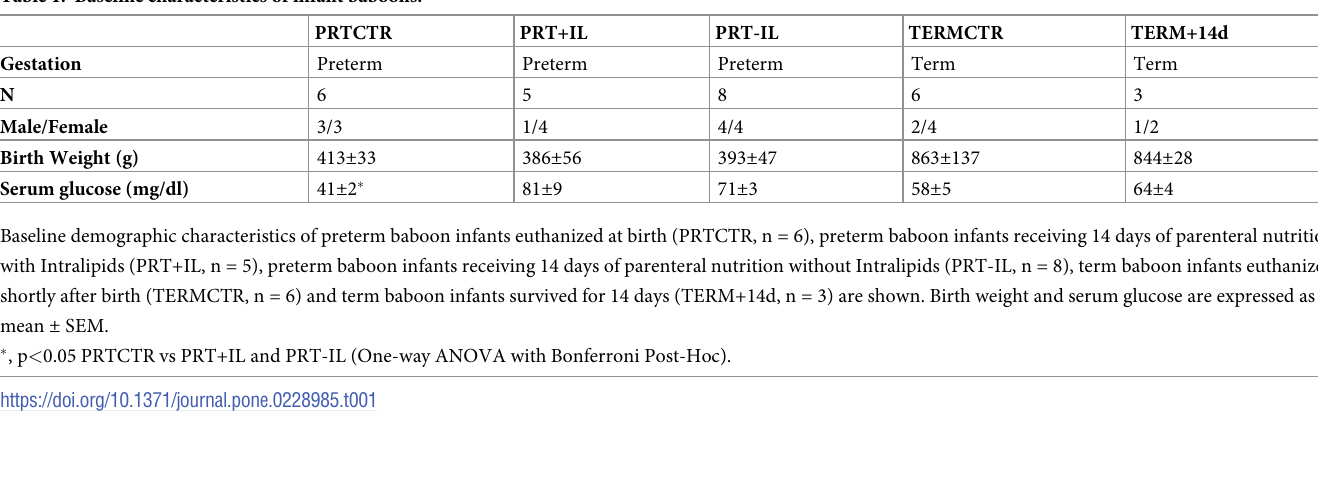
Table 1. Baseline characteristics of infant